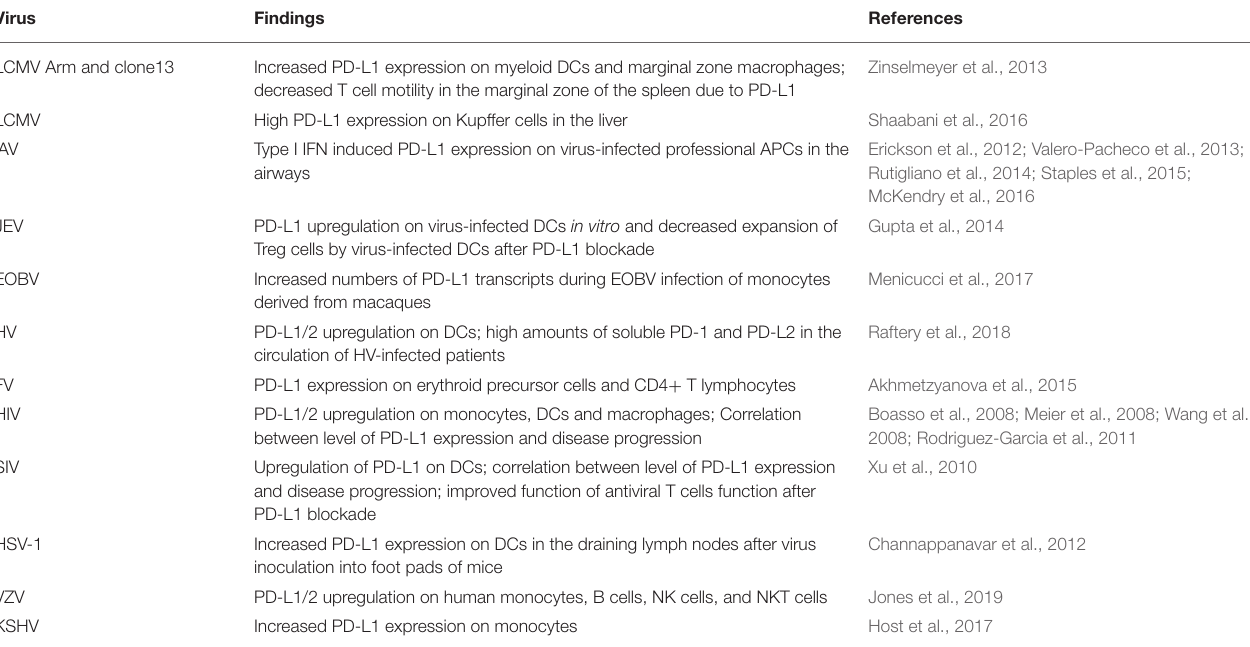
TABLE 1 | Virus-induced upregulation of PD-1 ligands on hematopoietic cells. Virus Findings